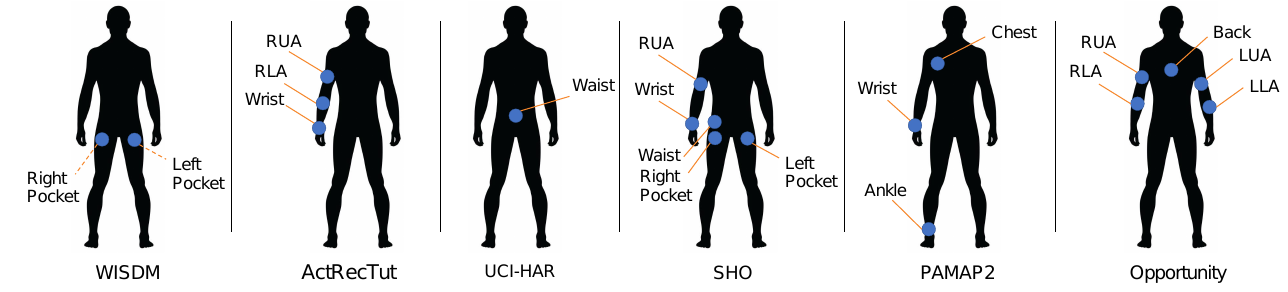
Figure 4. Placement of inertial sensors in different datasets: WISDOM; ActRecTut; UCI-HAR; SHO; PAMAP2; and